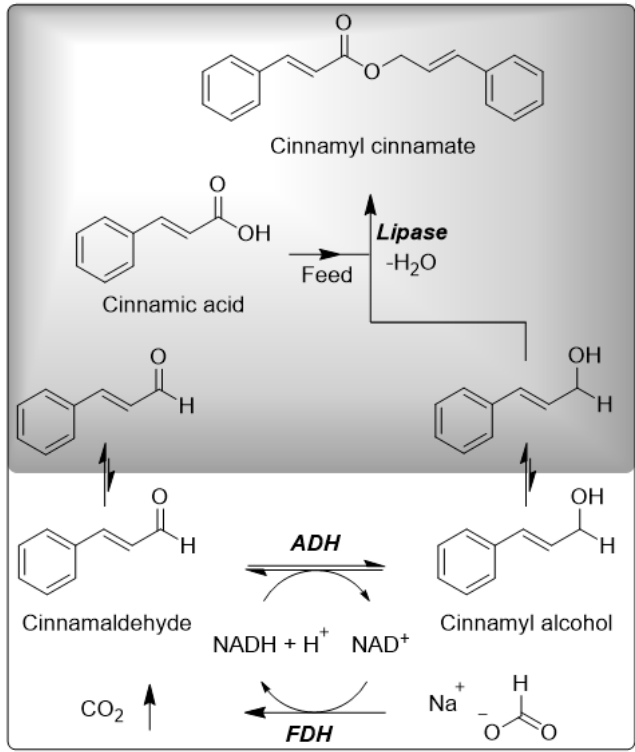
Figure 1. Reaction scheme of the multienzyme cascade.